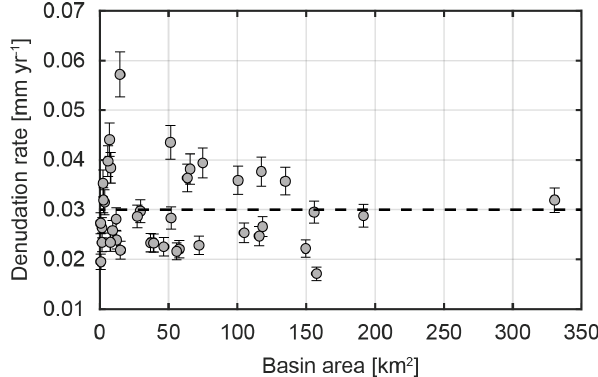
Figure 1. Basin-wide denudation rate variability as a function of drainage area in the Great Smoky Mountains. Original dataset from Matmon et al. (2003a, b); denudation rates reprocessed by Portenga and Bierman (2011). Dashed black line shows the estimated back- ground uplift rate for the region of 0.03mmyr − 1